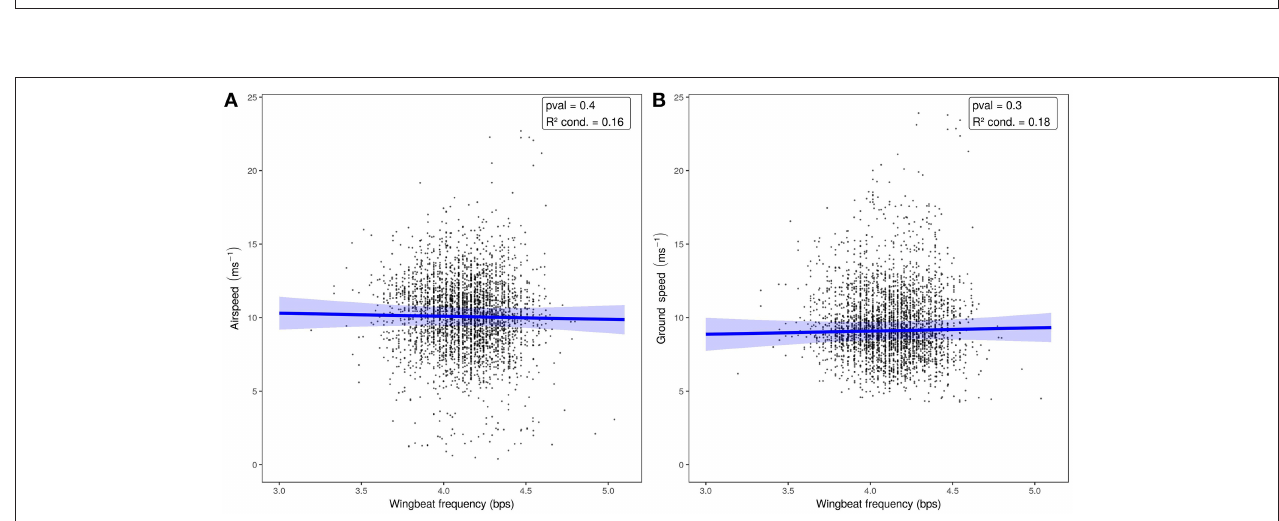
Frontiers in Ecology and Evolution | www.frontiersin.org